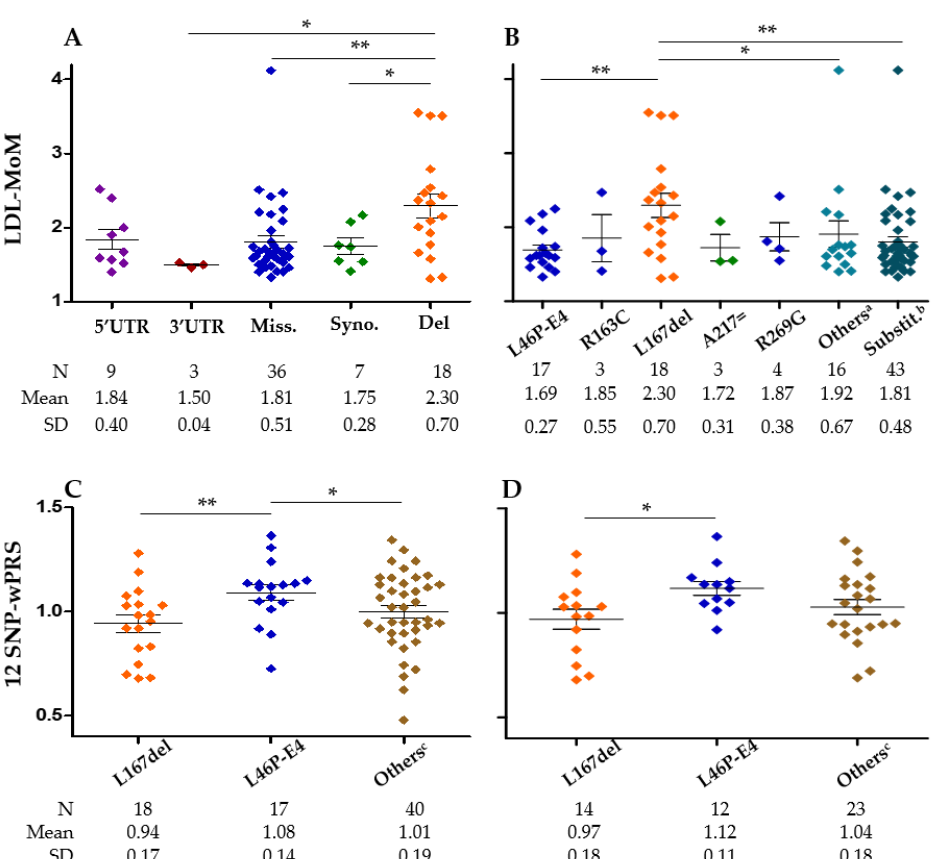
Figure 5. Multiple of median for LDL-C (LDL-MoM) and weighted polygenic risk score (wPRS) among carriers of different variants. ( A ) LDL-MoM in carriers of 5’UTR, 3’UTR, missense, synony- mous, and deletion variants for the whole cohort. ( B ) LDL-MoM in carriers of exonic variants for the whole cohort. a Other exonic variants than the five shown in the graph because with at least three carriers, b All exonic substitutions. ( C ) wPRS in carriers of p.Leu167del, p.Leu46Pro/E4, and other variants for the whole cohort. ( D ) wPRS in the carriers of p.Leu167del, p.Leu46Pro/E4, and other variants in the ADH cohort. c Variants other than p.Leu46Pro-E4 and p.Leu167del (exonic, intronic, 5’ and 3’ UTR). * p<0.05, ** p<0.005, non-parametric Mann–Whitney test.